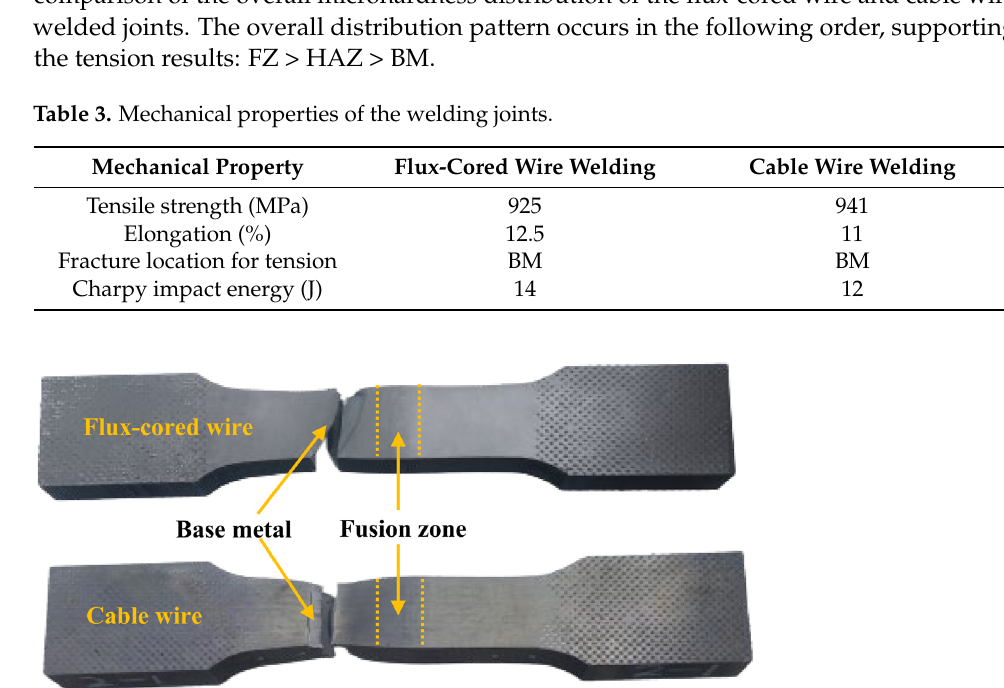
Figure 13. Tensile specimen fracture location of flux-cored wire and cable wire welding joints.